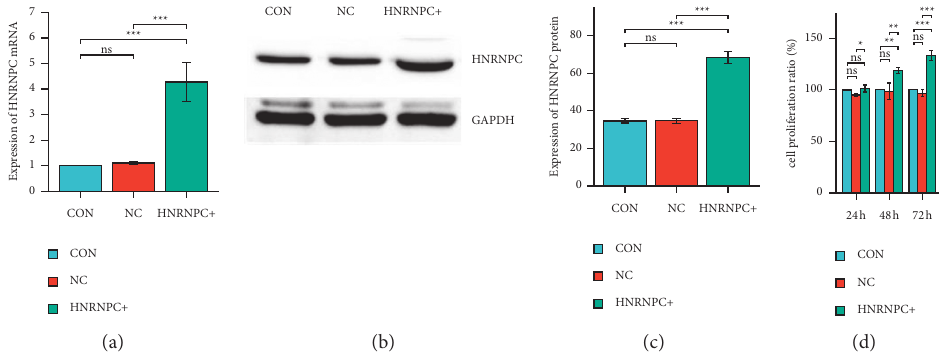
Figure 5: The effect of overexpression of HNRNPC on the proliferation of PC12 cells. (a) Detection of HNRNPC mRNA expression in each group by qPCR. (b, c) Detection of HNRNPC protein expression in each group by western blotting. (d) Detection of cell proliferation ratio in each group by CCK-8. CON: control group, NC: empty plasmid group, HNRNPC+: overexpression HNRNPC group.